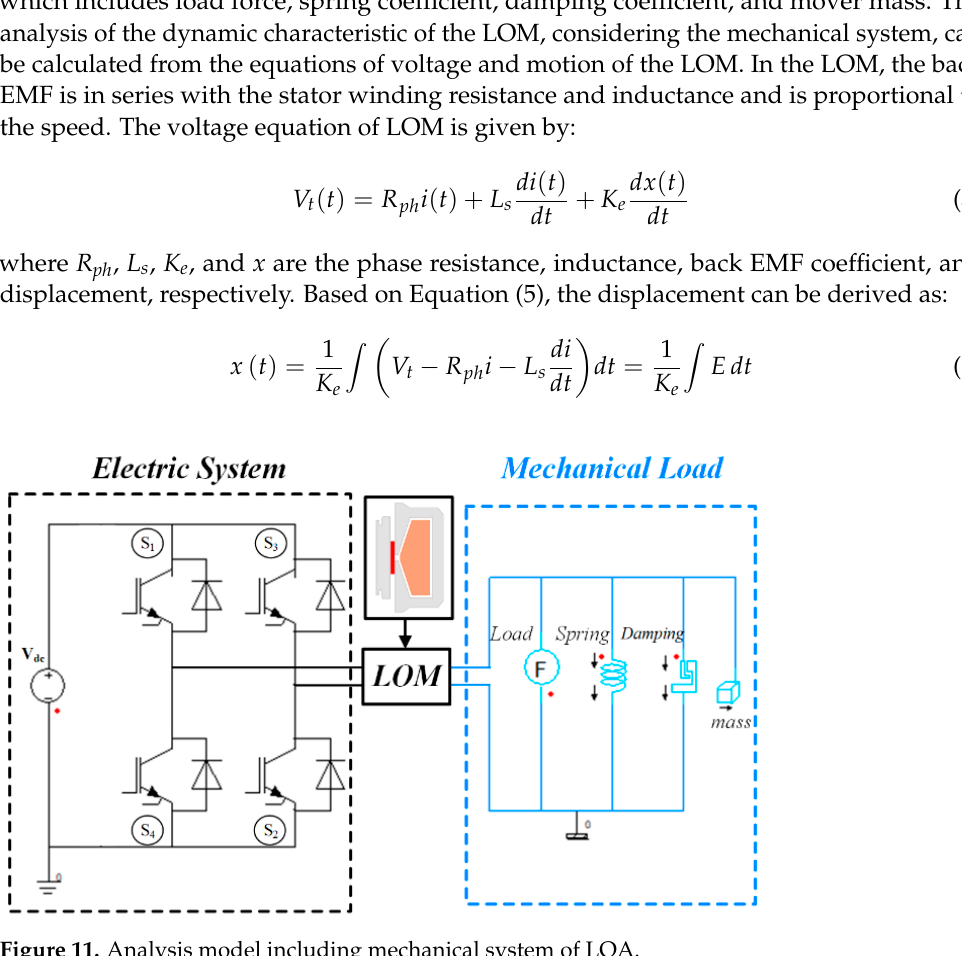
Figure 11. Analysis model including mechanical system of LOA. Table 2. Parameters for dynamic analysis of LOM.